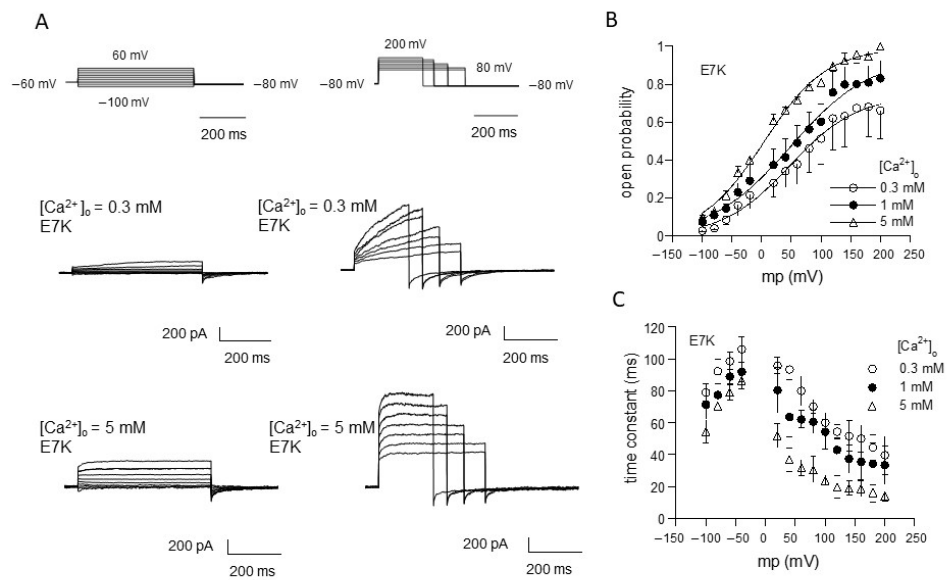
Figure 1. Evaluation of E7K-TRPM4 channel gating by voltage-jump experiments. ( A ) actual traces of E7K-mutant TRPM4 channel currents responding to a set of voltage pulses from − 100 to 60 mV (left row) and 80 to 200 mV (right row) by 20 mV steps. In each row, top panels show voltage pulses, while middle and bottom panels show corresponding TRPM4-mediated currents at 0.3 and 5 mM Ca 2+ in the bath. The TRPM4-mediated currents were recorded by Ion-C/A recording where 5 µ M ionomycin-containing Ca 2+ -free solution was applied onto the cell immediately after giga-seal formation to permeabilize the cell membrane, which was then switched to solutions with various concentrations of extracellular Ca 2+ ([Ca 2+ ] o ) to activate the current. All these agents were applied through a fast solution device ‘Y-tube’. It should be noted that the level of a rise in intracellular Ca 2+ concentration ([Ca 2+ ] i ) corresponding to a given [Ca 2+ ] o , which was separately determined by Ca 2+ imaging experiments, was almost stable and did not involve Ca 2+ release from internal stores [13]. ( B , C ) the relationship of open probability (P o ) versus membrane potential ( B ) and that of time constant ( τ ) of activation/deactivation time courses during voltage pulses ( C ). Different symbols and bars in the figure denote mean ± S.E.M. from five independent experiments. Smooth curves in A are drawn according to the best fits of data points (normalized to the maximum) by the Boltzmann equation: 1/[1 + exp( − (V m − V 0.5 )/s), where V m , V 0.5 and s denote membrane potential, half-activation voltage and slope factor, respectively. The values of these parameters are 47.542, 48.825 and 3.697 mV, and 56.582, 67.327 and 52.844 mV for 0.3, 1 and 5 mM [Ca 2+ ] o , respectively. To more unequivocally elucidate the altered gating by the ‘E7K’ mutation, we cal- culated the rate constants of opening ( α ) and closing ( β ) from the voltage and Ca 2+